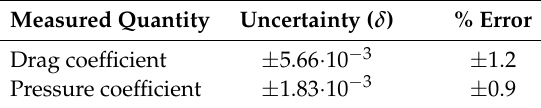
Table 2. Evaluated uncertainties and